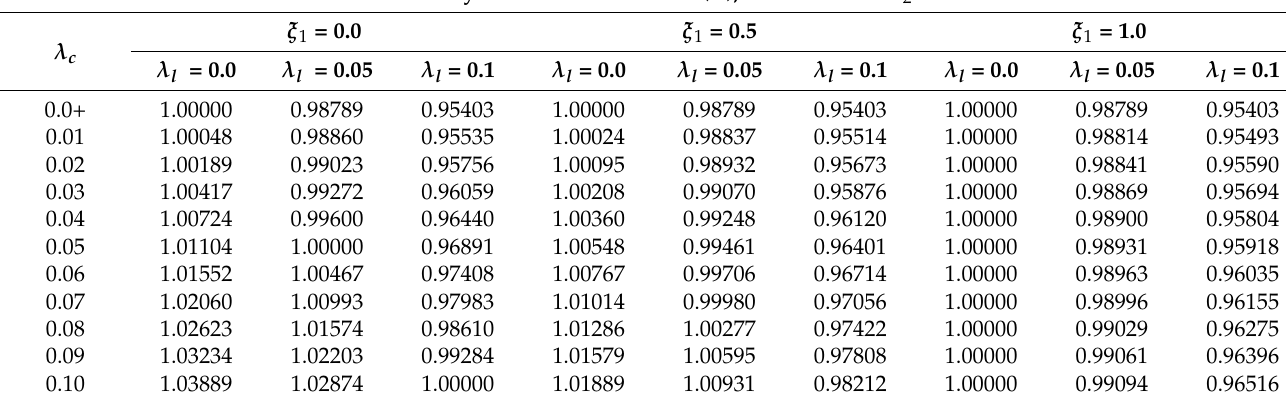
Table 3. Normalized fundamental flexural frequency of simply supported nano-beam of pure polymeric matrix for T = C = 0.